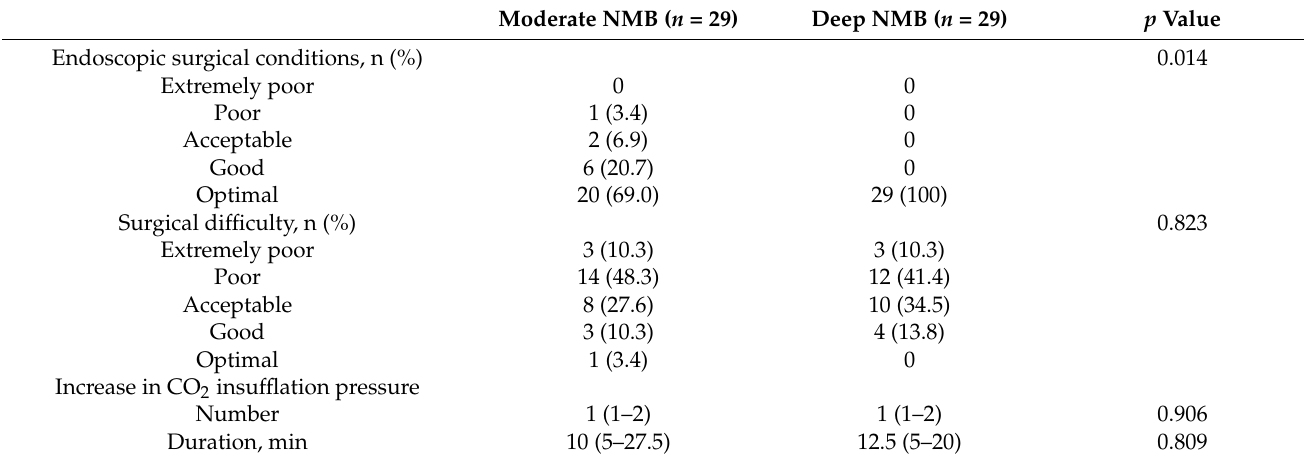
Table 2. Surgical conditions and difficulty.